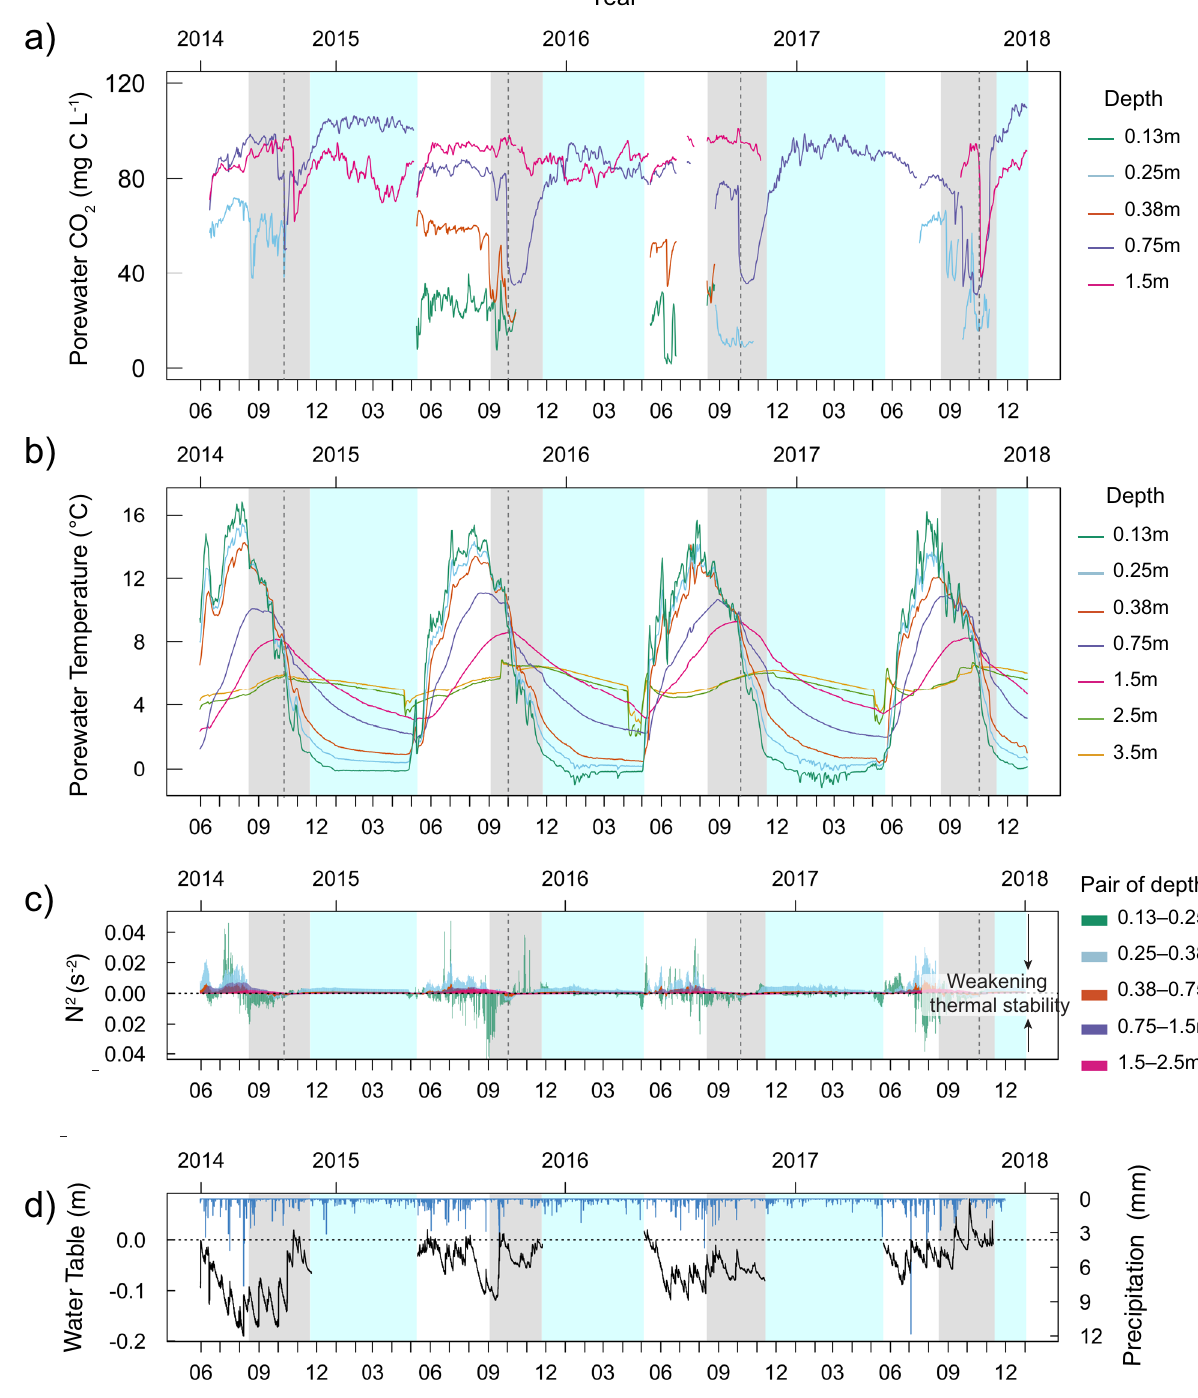
porewater CO 2 concentration increased sharply with depth, which resulted in a persistent convex pro fi le from May to August (Fig. 3a). This convex vertical CO 2 concentration gradient is consistent with slow vertical diffusive transport 17 . During the autumn, the porewater CO 2 depth gradient suddenly became linear with depth (Fig. 3b) or sometimes collapsed completely between two adjacent porewater depths (Fig. 3d). There were also